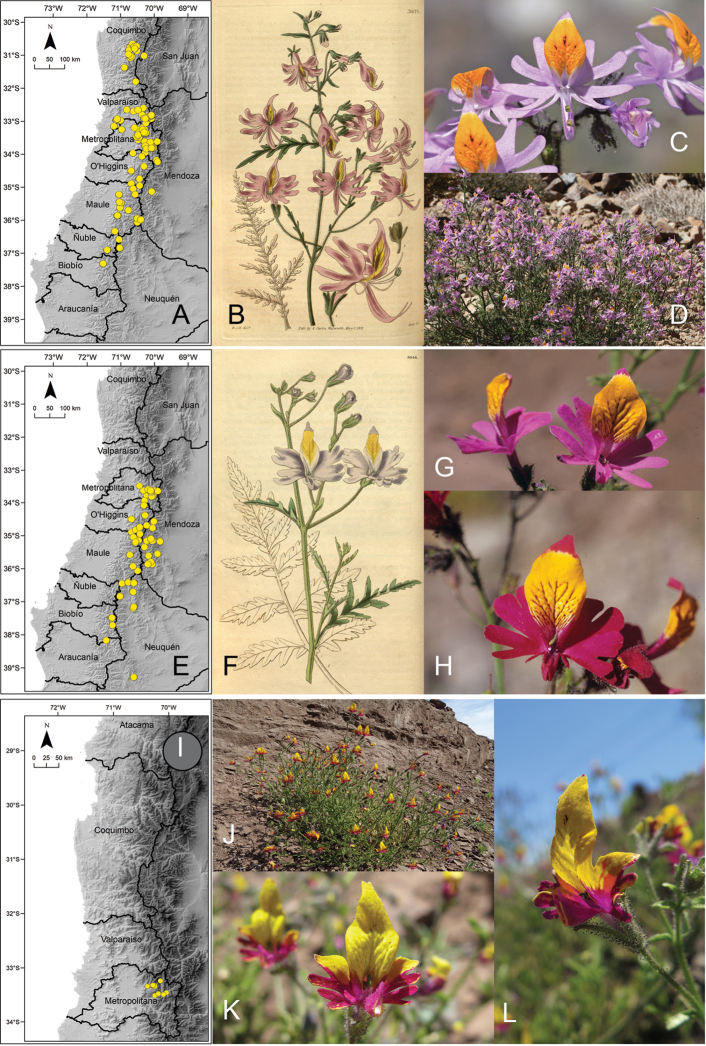
A distribution of Schizanthus
hookeriB illustration of S.
hookeri published with the description of the species (Graham 1830) C examples of Schizanthus
hookeri in Juncal Andean Park D La Campana National Park E distribution of Schizanthus
grahamiiF illustration of S.
grahamii published with the description of the species (Hooker 1831a) G examples of S.
grahamii in Paso Vergara H Termas del Flaco I distribution of Schizanthus
coccineusJ–L examples of S.
coccineus in La Parva (Metropolitan Region). Photos by M. Aldunate (C), A. Moreira-Muñoz (D, K), S. Moreira (G, H), C. Jirón (J), V. Morales (L).